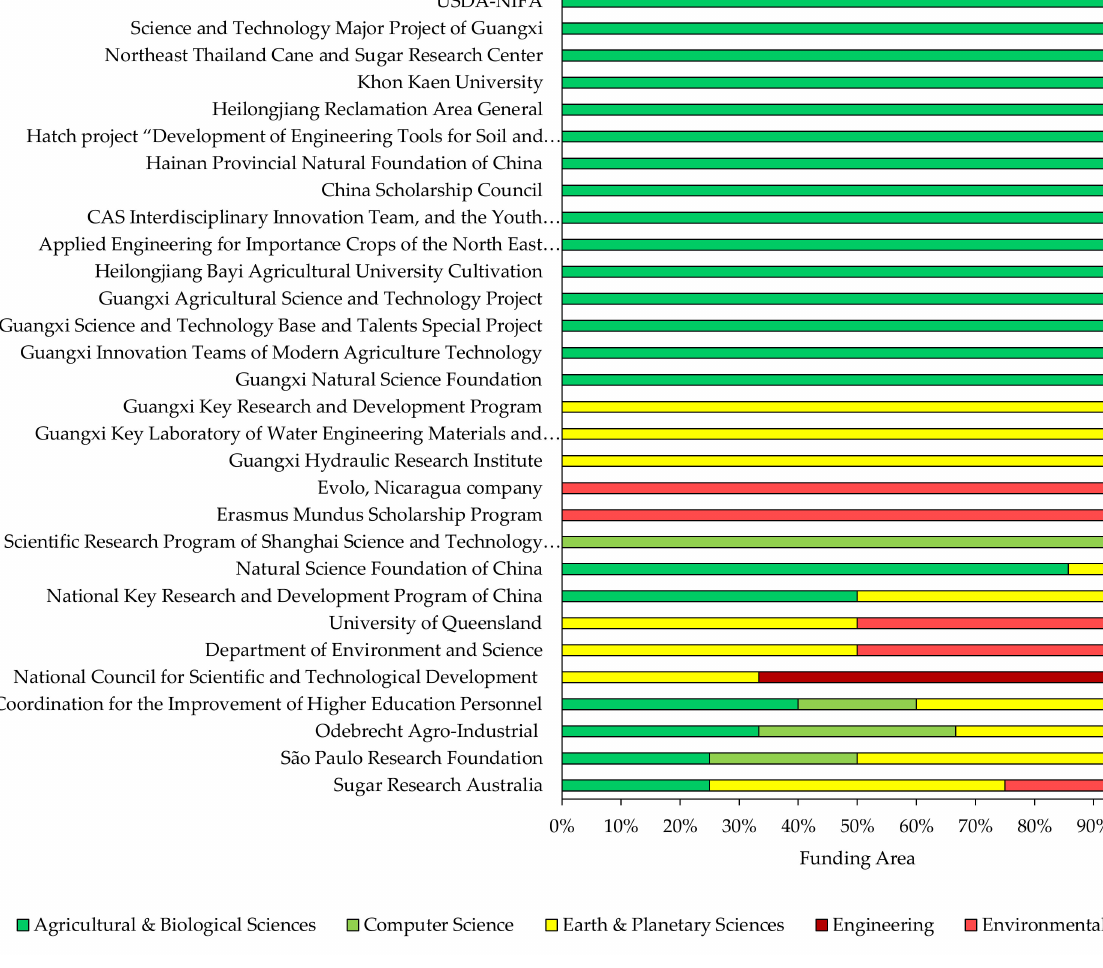
Figure 5. Most active financing institutions and funding-absorbing fields of research in UAVs for